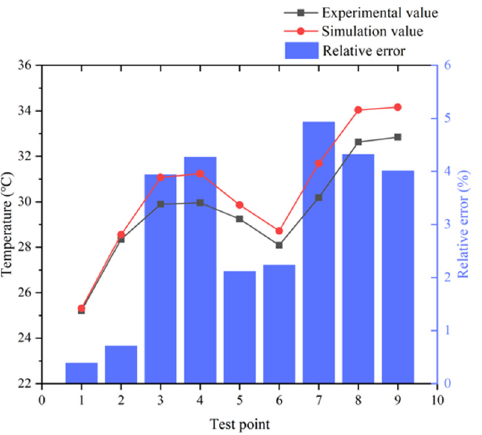
Figure 5. Comparison of measured and numerical simulated values of the outlet temperatures of rack B4.